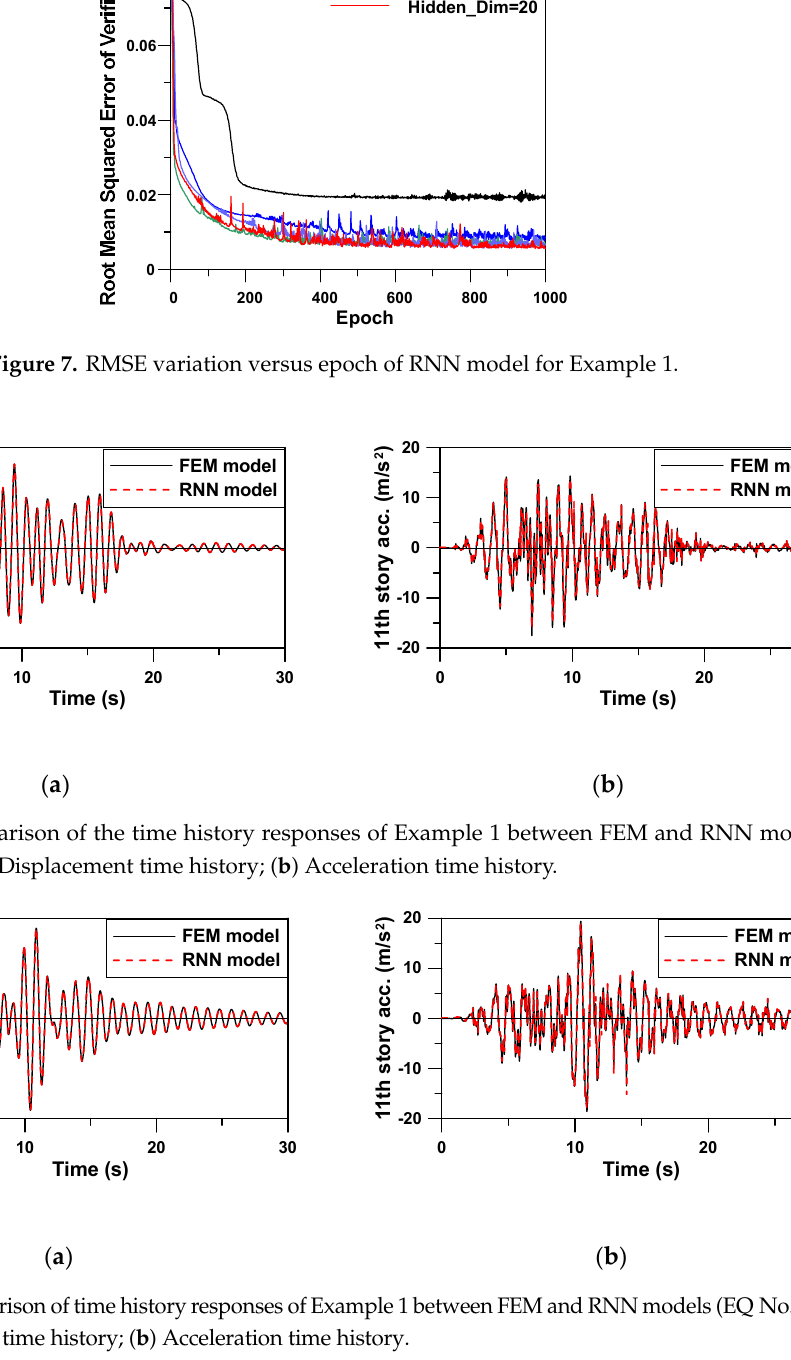
( b ) Figure 10. Comparison of time history responses of Example 1 between FEM and RNN models (EQ No. 13): ( a ) Displacement time history; ( b ) Acceleration time history. The same hyperparameter values and functions applied to Example 1 were used to evaluate the prediction performance of the RNN model trained for Example 2. Because the outputs of the RNN model for Example 2 were four seismic responses, Figures 11–13 compare four response time histories predicted by the RNN model with those of the FE model. It is evident that the predicted responses were very close to the target responses of the FE model. Note that the trained RNN model shows a stable prediction performance for ground motions having different characteristics, despite the peak top story displacement of Jiji earthquake (1999), i.e., the verification earthquake No. 13, being almost 10 times greater than that of the other two artificial earthquakes, i.e., the verification earthquakes Nos. 11 and 12. The average RMSE values for four seismic responses of three verification data from EQ No. 11–13 in Table 2 were 1.232 × 10 −3 , 1.103 × 10 −3 and 5.249 × 10 −3 , respectively.